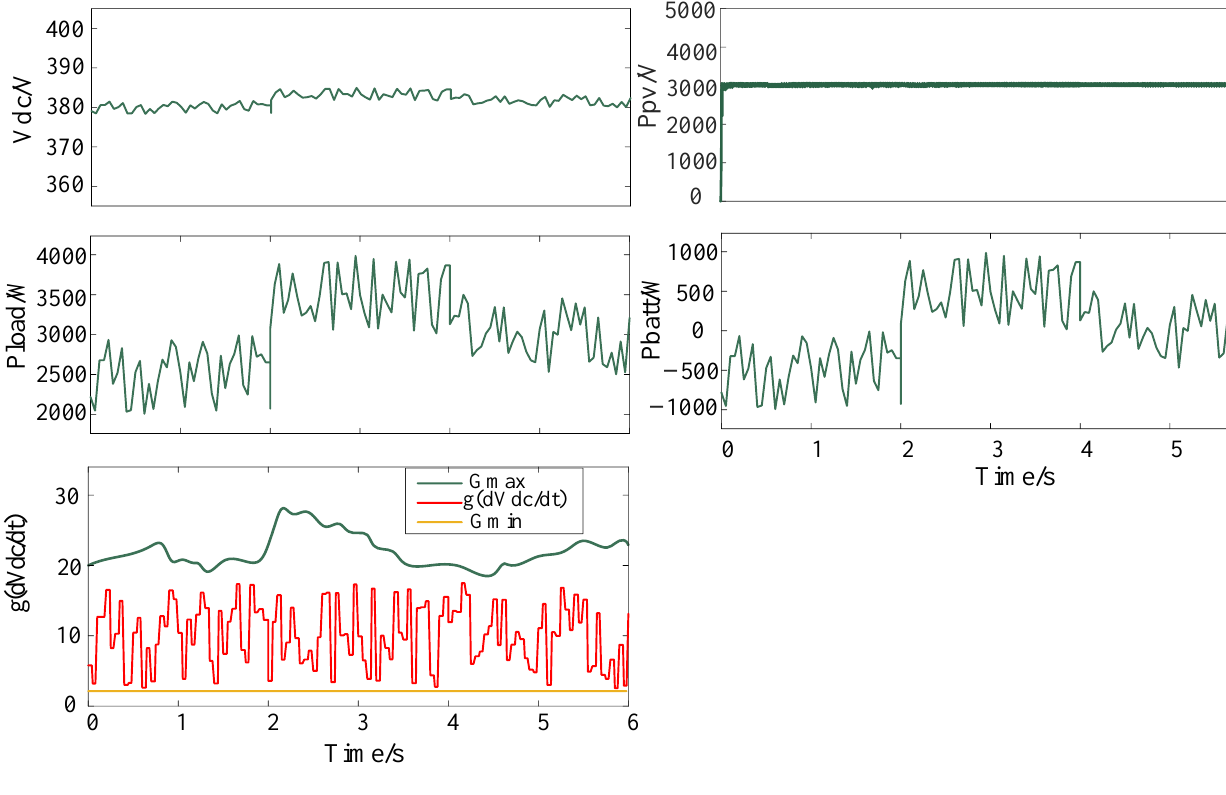
( b ) Figure 10. Experimental results for sudden load power change. ( a ) Load power suddenly decreases to 1 kW; ( b ) load power suddenly increases to 2 kW. It can be seen that, compared with the TDPI method, the DC bus voltage with the proposed CC method has a smaller fluctuation range, which is caused by the load power mutation, and the battery converter can adjust the charging and discharging power more quickly. In other words, the proposed CC method can not only effectively suppress the DC bus voltage fluctuation and improve the stability of the bidirectional DC/DC con- verter but also produce a fast dynamic response when the system load changes. Figure 11a,b show the comparison of the results for the battery converter output voltage V dc with the proposed CC and TDPI methods when the reference value of the battery converter output voltage V dc ref suddenly increases from 200 V to 225 V and de- creases from 250 V to 210 V, respectively.